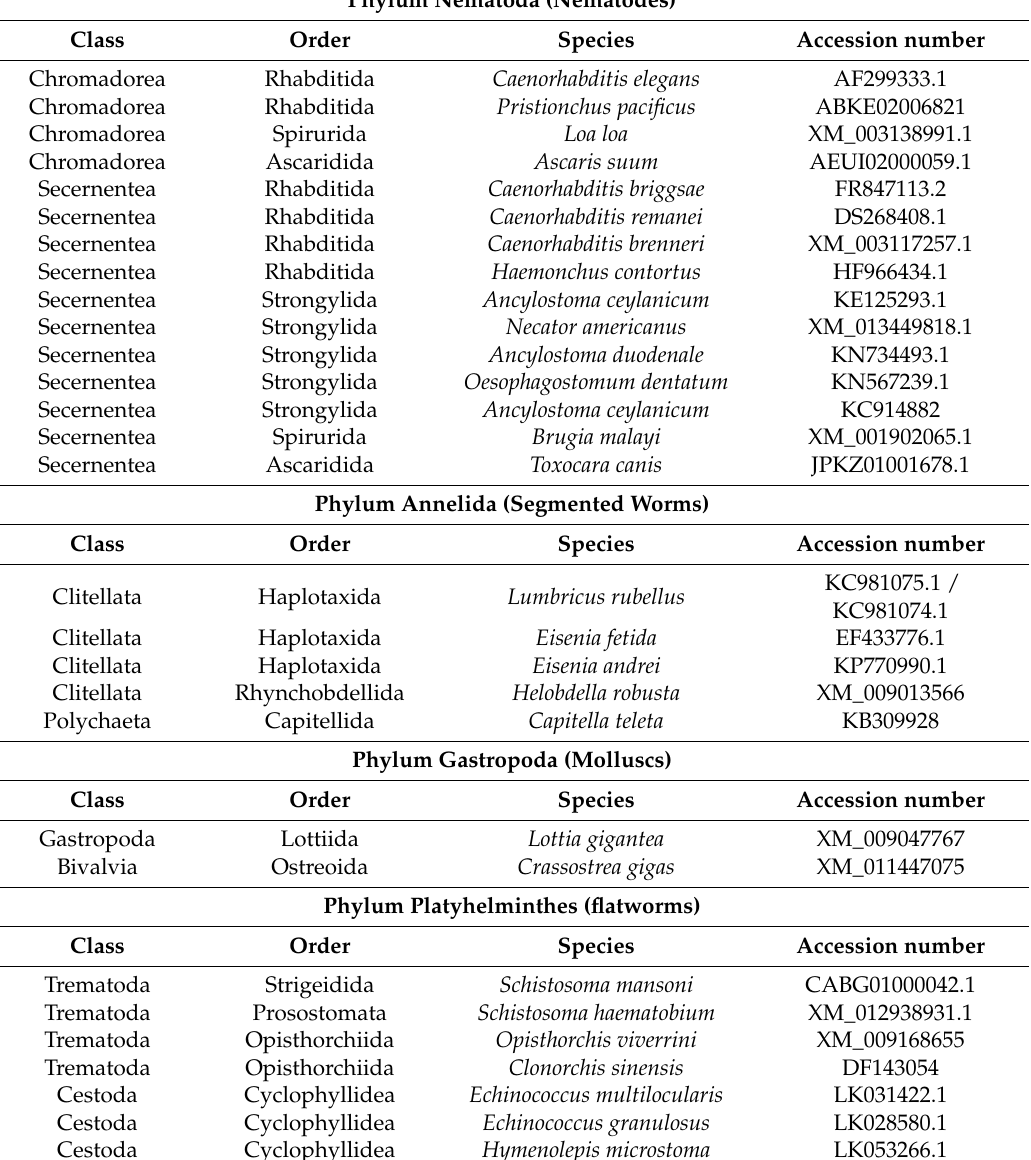
Table 1. Phytochelatin synthases/glutathione gamma-glutamylcysteinyltransferases identified within the Kingdom